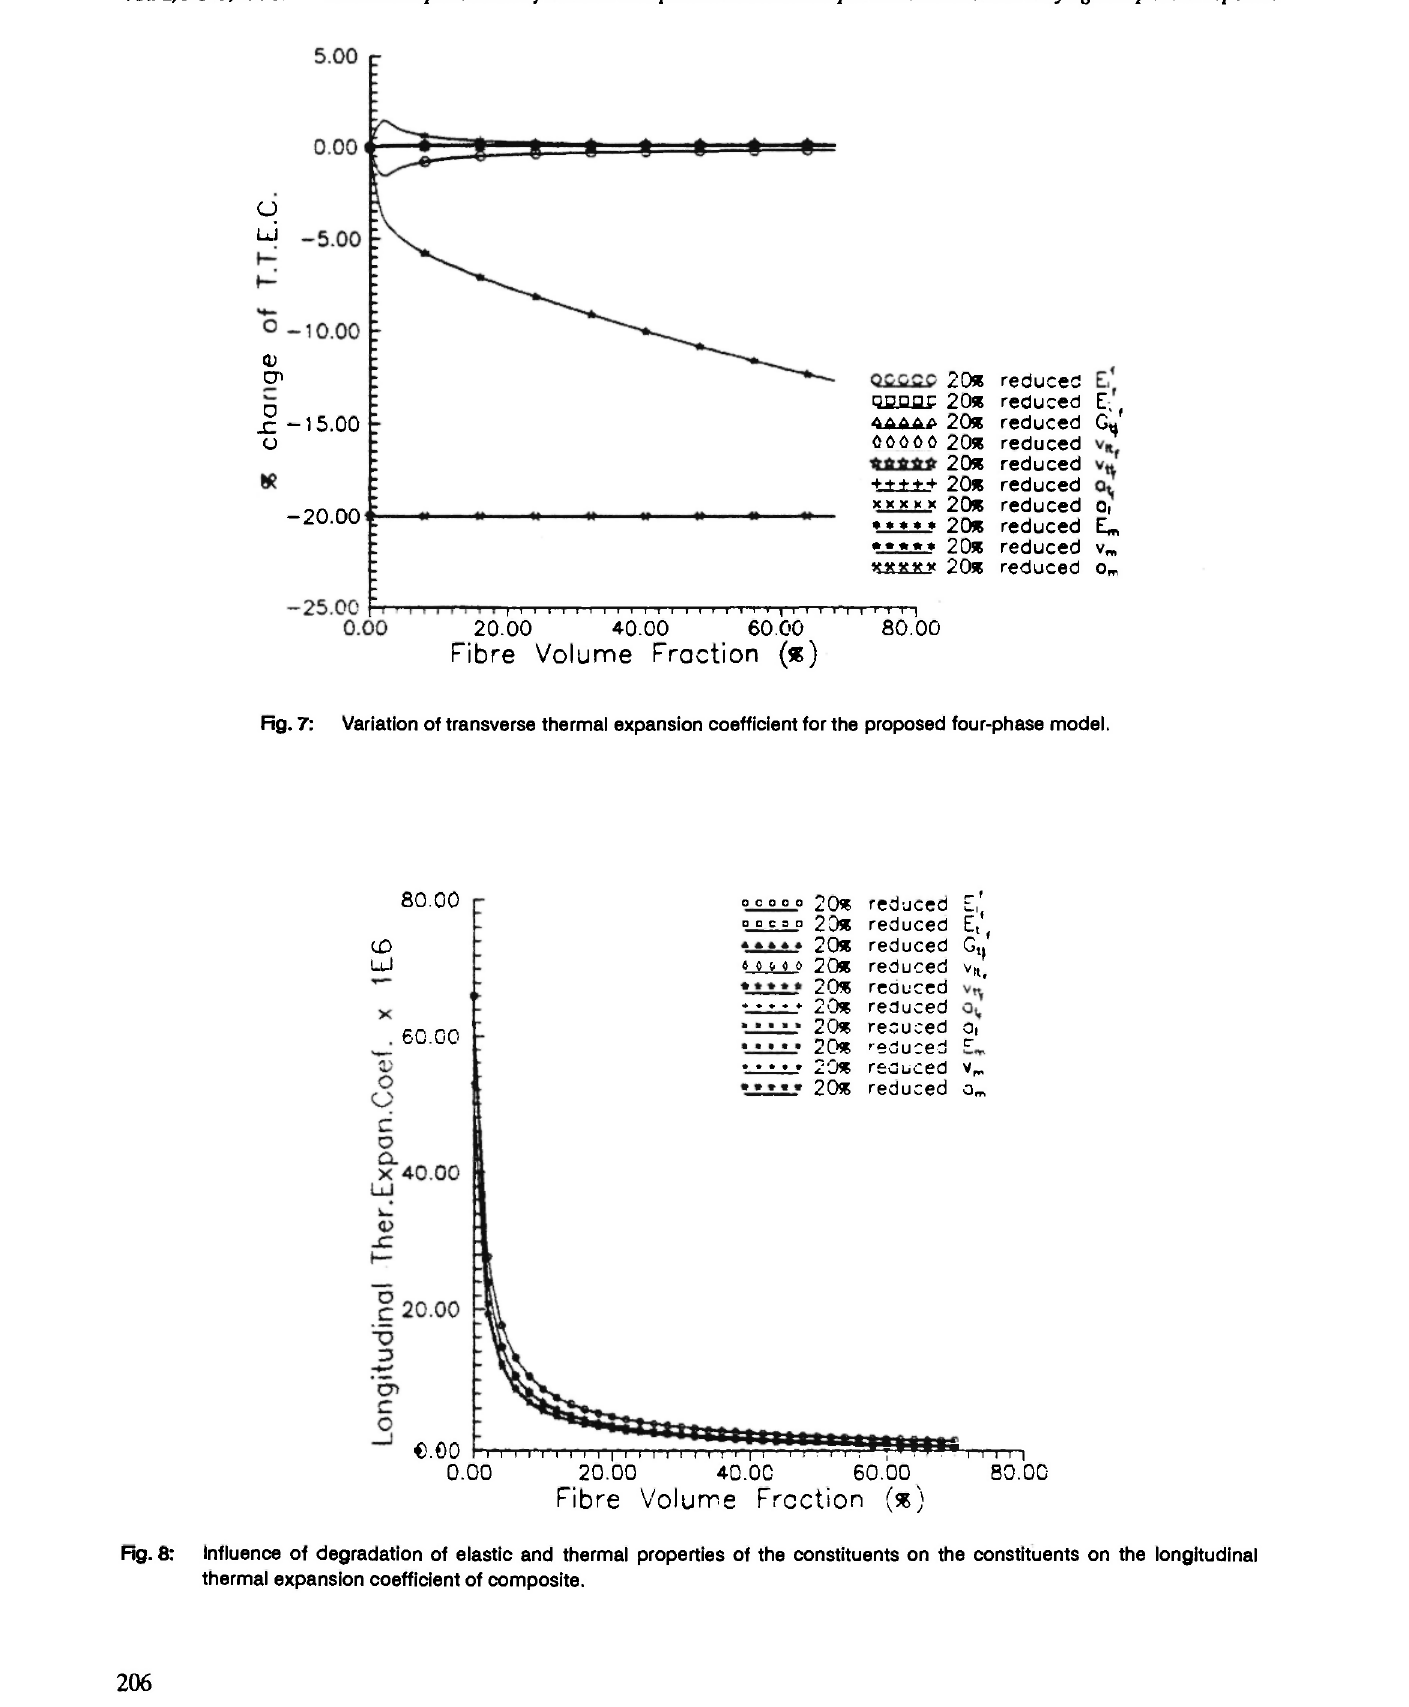
Fig. 8: Influence of degradation of elastic and thermal properties of the constituents on the constituents on the longitudinal thermal expansion coefficient of